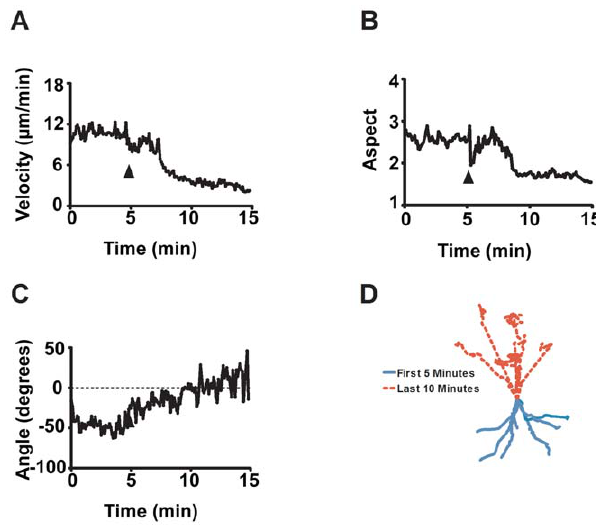
Figure 4. Analysis of Dictyostelium cell behaviour with addition of 5 mM copper sulphate after 5 Min. Mean data representing 124 cell chemotaxis over a 15 min period following addition of copper sulphate (5 mM) at 5 min (arrow) for A: cell velocity; B: cell aspect; C: cell angular movement; D: cell tracking (where the co-ordinates of individual cells were illustrated following normalisation to (0,0) at 5 min, represented by single lines for 0–5 min (blue) or 5–15 min (dashed red) and cell direction has been adjusted so that cells are moving up the page). Data from A–C is presented as a mean of triplicate experiments analysing approximately 40 cells in each.